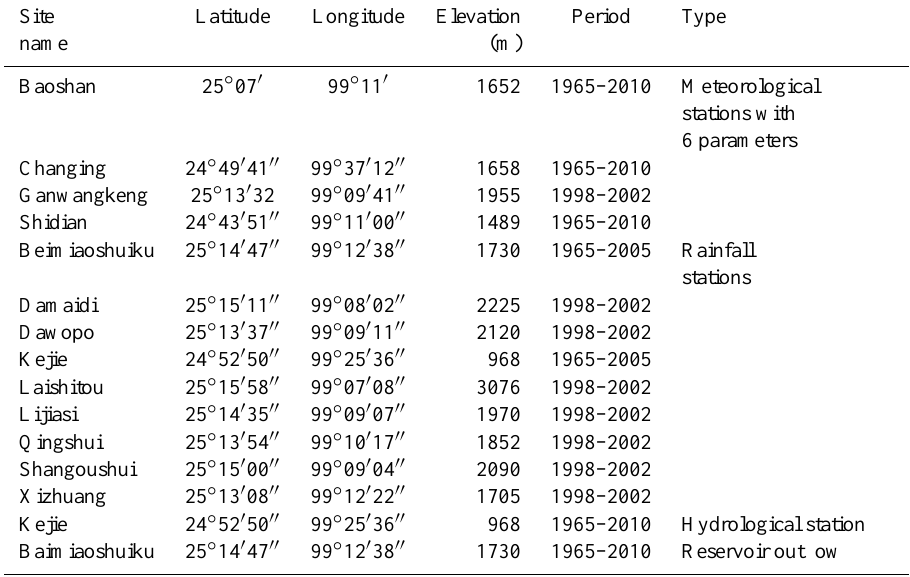
Table 1. Characteristics of hydro-meteorological stations in the Kejie watershed.